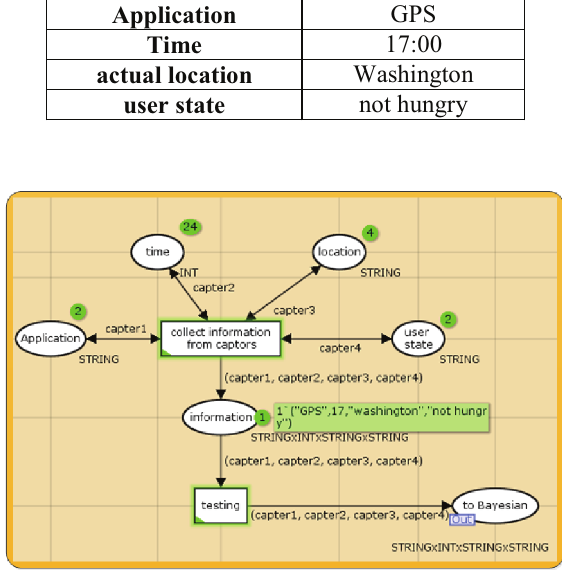
Fig. 14. Collect of information from captors